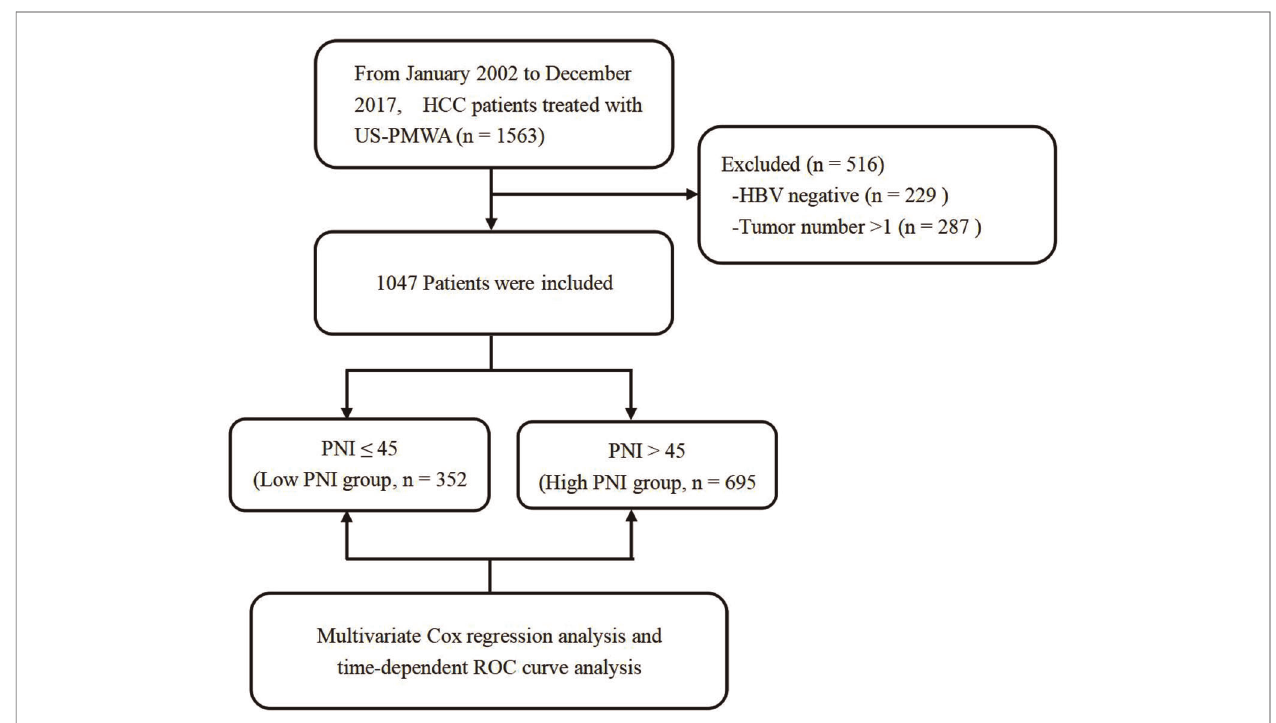
FIGURE 1 | Flow chart of patient selection and study